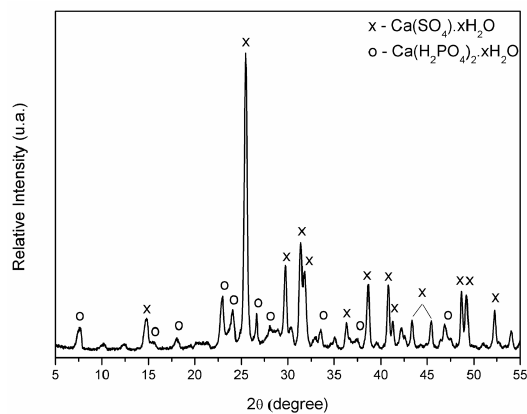
Figure 1. XRD pattern of original (not milled) SSP fertilizer.